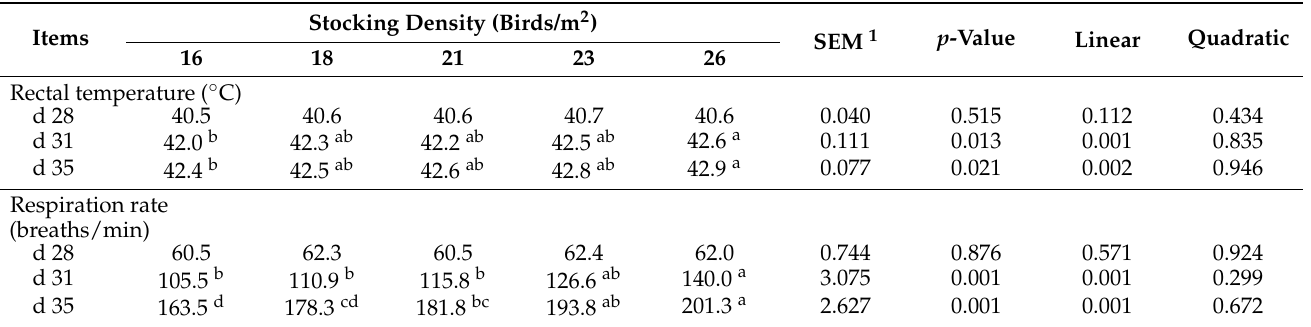
Table 2. Effects of stocking density on rectal temperature and respiration rate of broiler chickens under high temperatures.